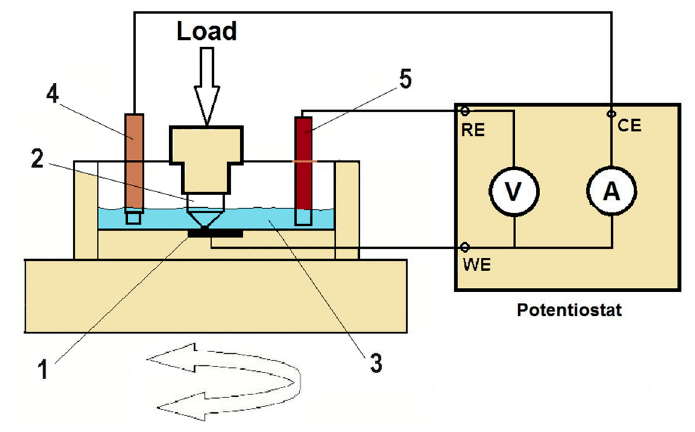
Figure 3. Friction pair and corrosion measurement system: 1—sample, 2—countersample, 3—electrolyte, 4—auxiliary electrode, 5—reference electrode.